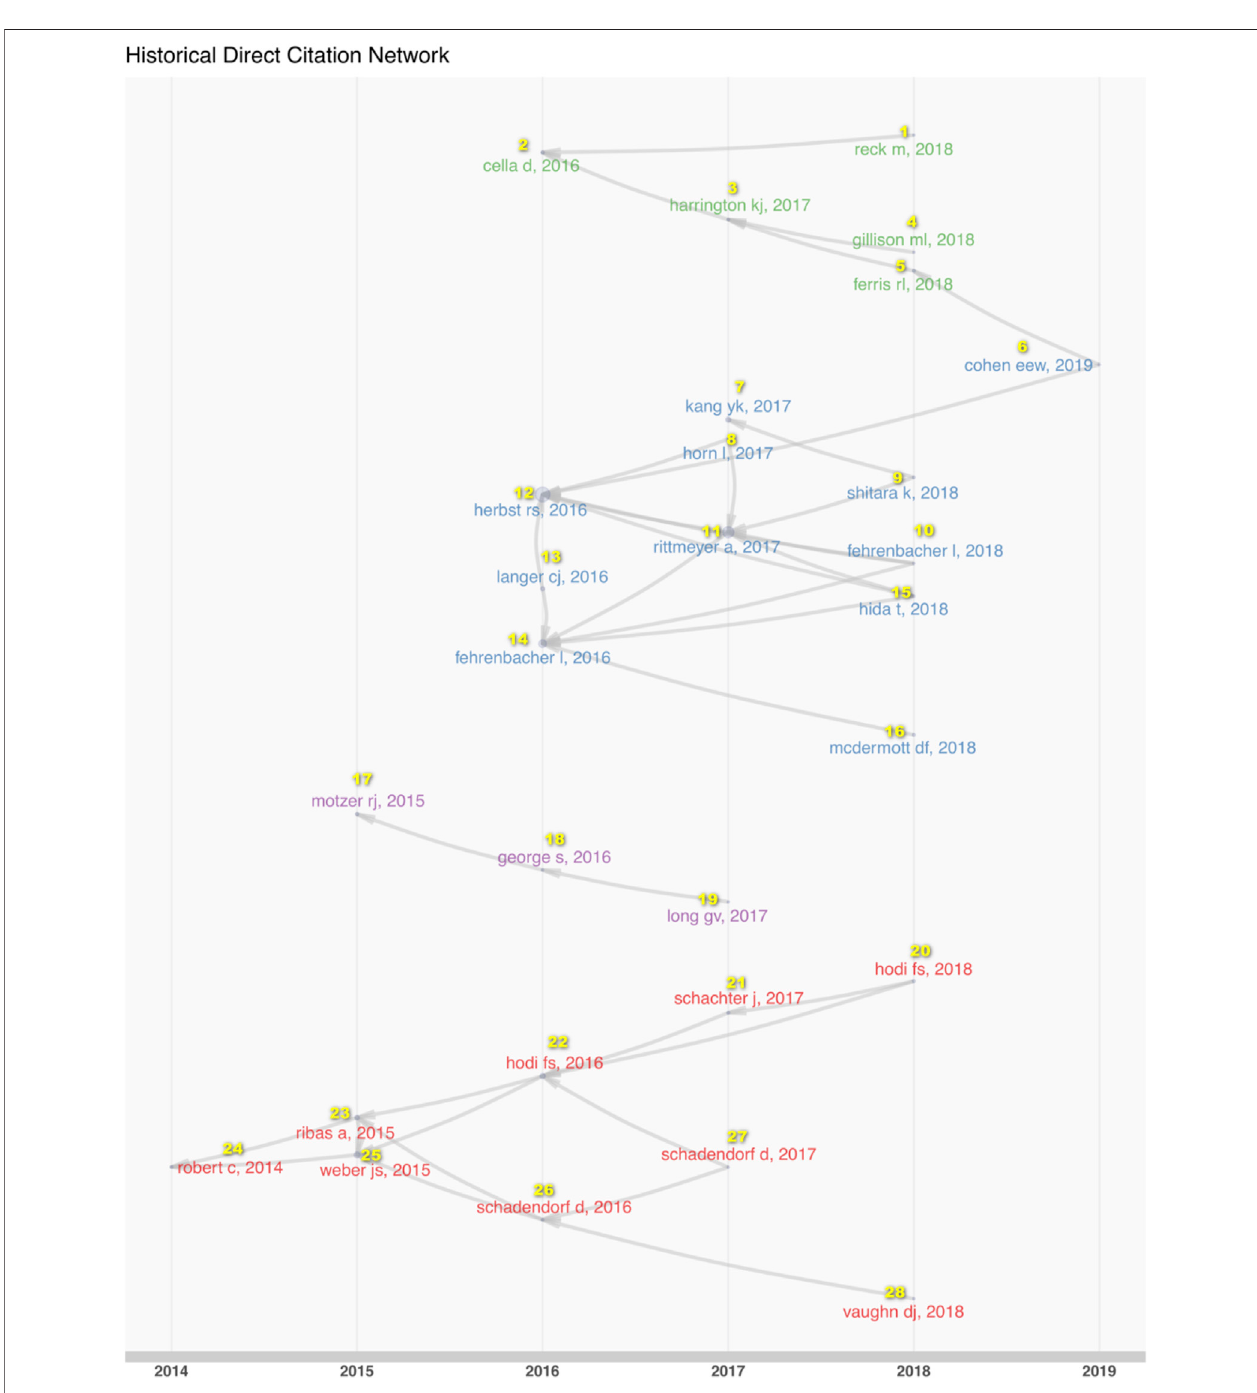
FIGURE 6 | The historical direct citation network in RCT of anti-PD1/PDL1. The links among documents represented the citation relationships in the dataset.